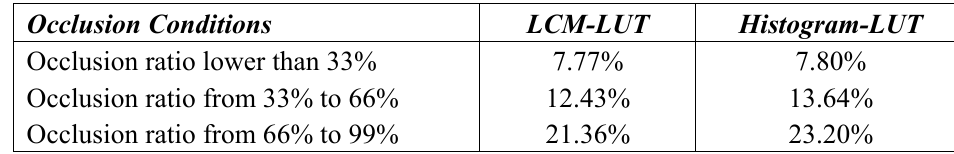
Table 3. Average relative error in the area estimate of red peaches for different occlusions.